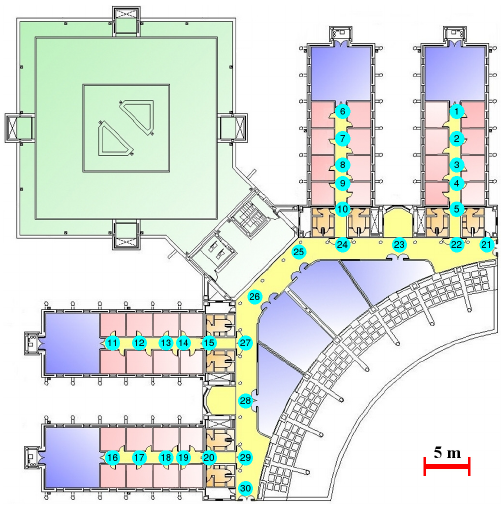
Figure 6. University of Alcalá (UAH) test-bed environment (30 topological positions). Figure 6. UAH test-bed environment (30 topological positions).